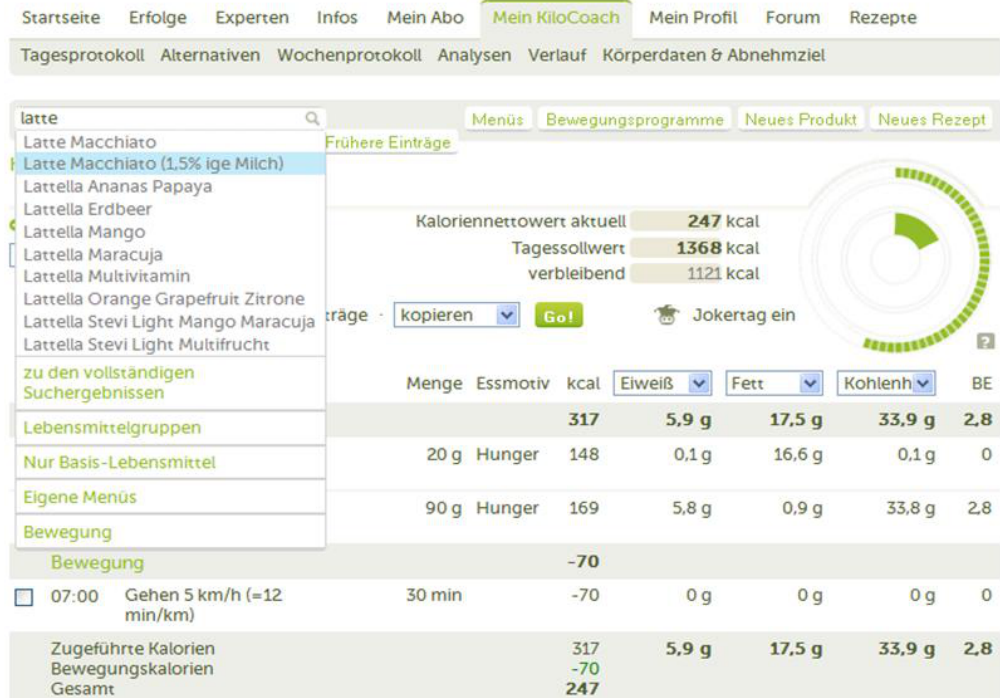
Figure 1. Screenshot of a dietary protocol in KiloCoach (see Multimedia Appendix 1 for